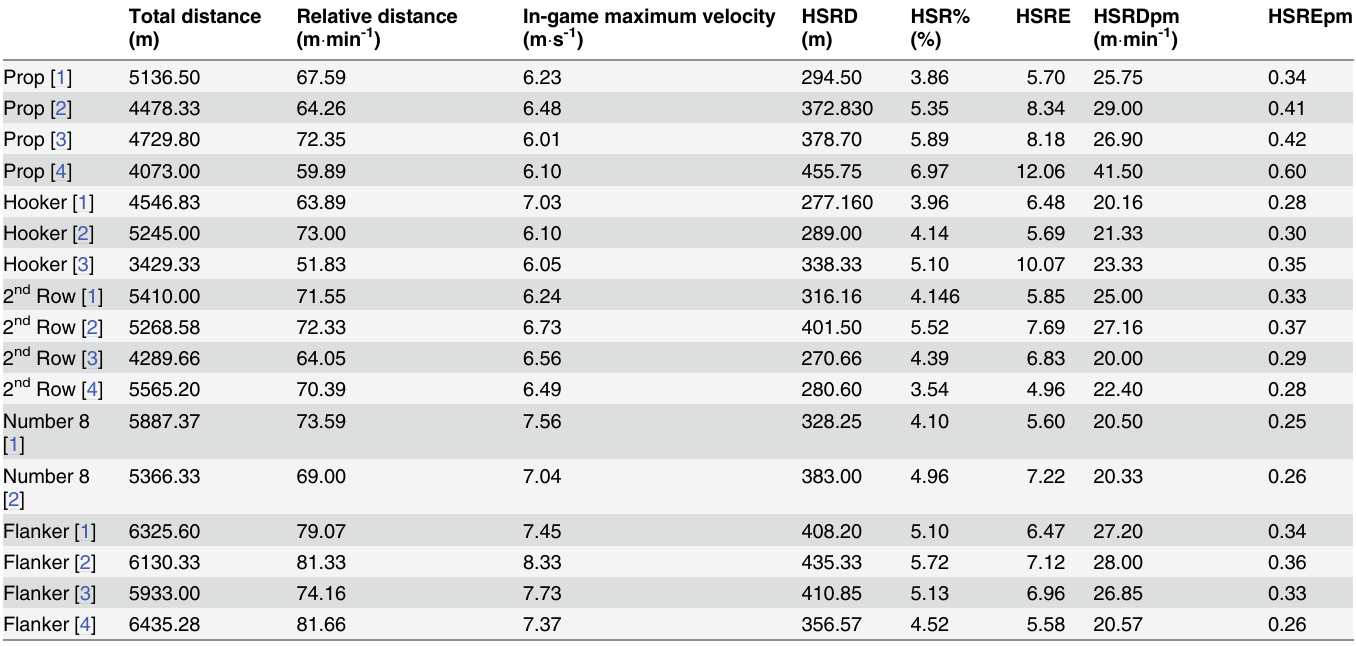
Table 7. Descriptive statistics on the IND HSR output of individual forwards players. Total distance (m)